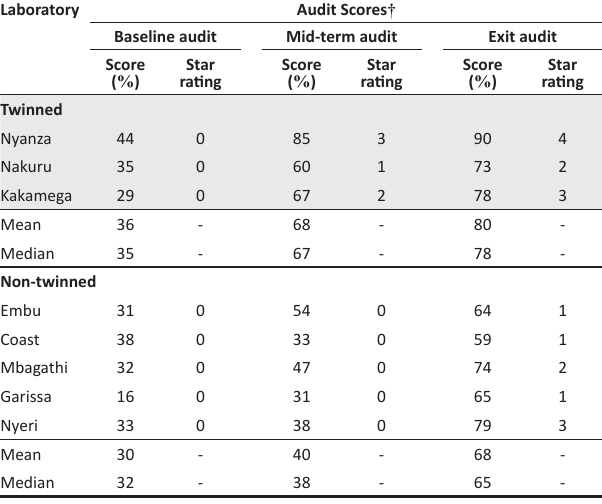
TABLE 3: Summary of audit results at baseline, mid-term, and exit of the Strengthening Laboratory Management Toward Accreditation (SLMTA) programme, Kenya 2010.